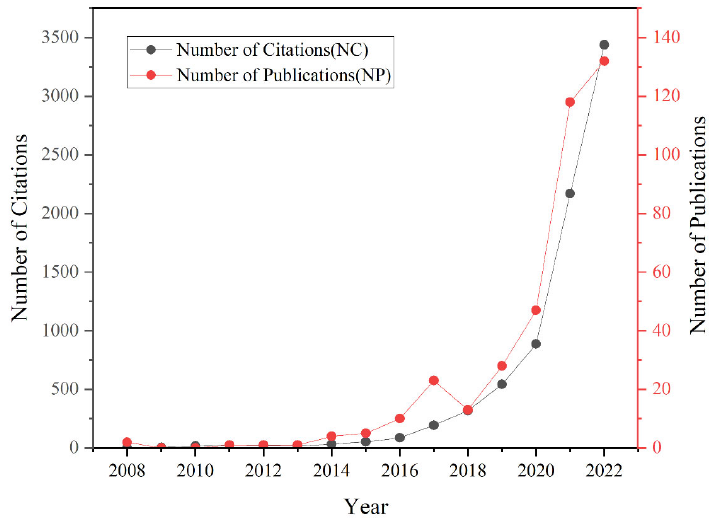
Figure 1. The trend of the number of publications (NP) and citations (NC) regarding NPs enhancing abiotic tolerance in plants from 2008 to 2022.